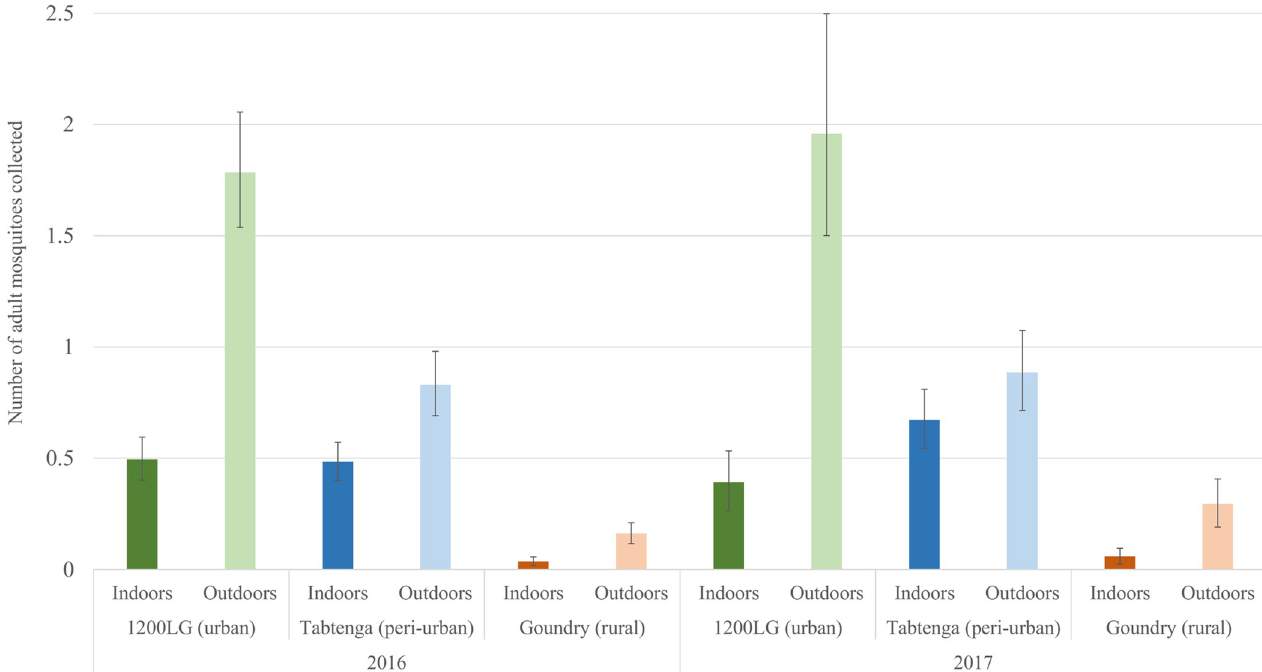
Fig 1. Indoor and outdoor resting behavior of adult female Ae . aegypti in domestic housing in Ouagadougou. Geometric means and 95% confidence limits of numbers of Ae . aegypti adults collected indoors and outdoors per house, in the three localities in 2016 and 2017.